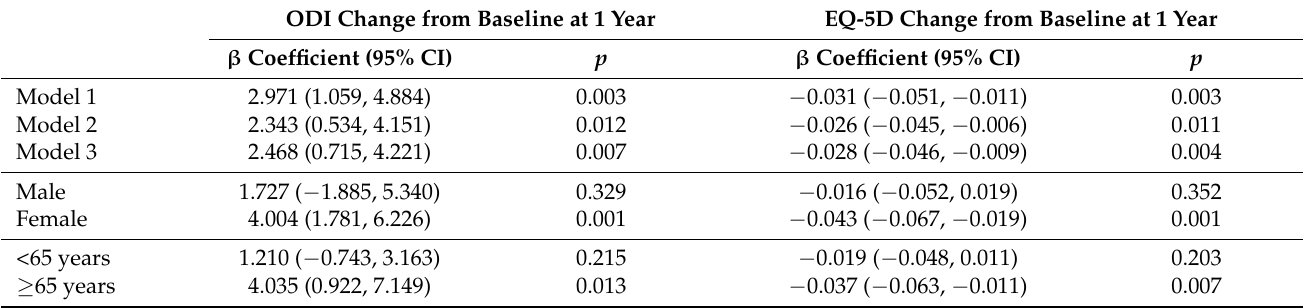
Table 4. Associations of superior foraminal width with change from baseline in ODI and